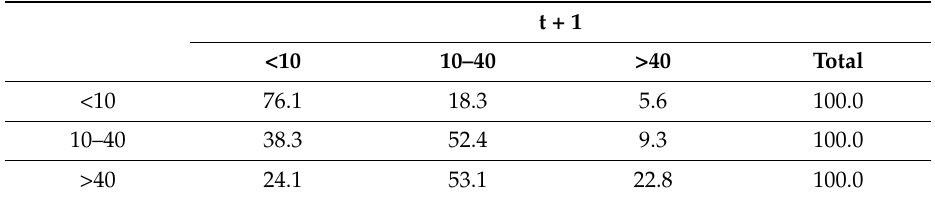
Results for transition probability analysis of catastrophic health expenditure in cancer